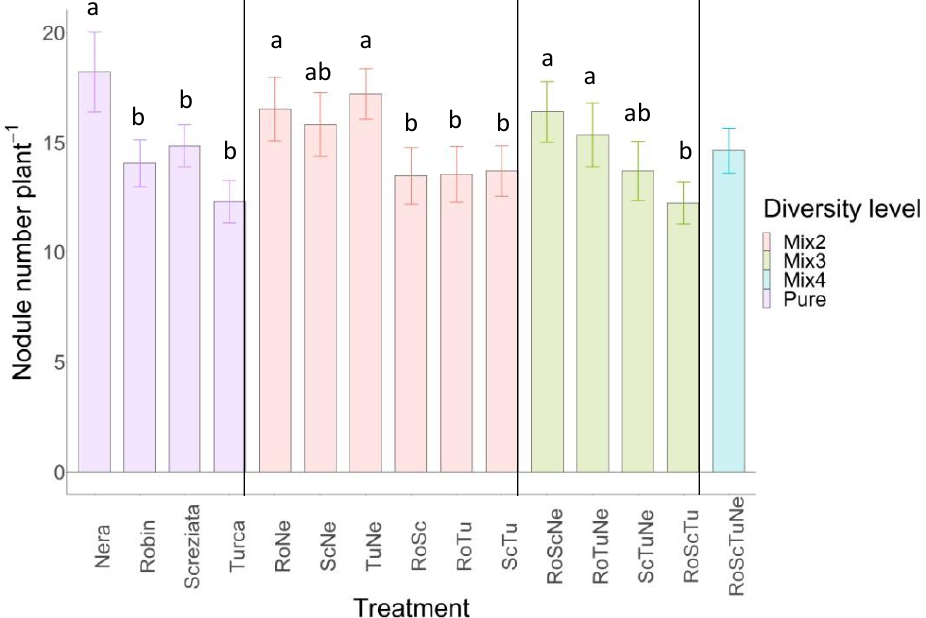
Figure 2. Nodule number per plant in pure lentil stands, two-, three- and four-cultivar mixtures, averaged over the three years of the experiment. Different letters indicate significant differences among treatments at p ≤ 0.05 (Bonferroni-based method). Ne = cv. Nera, Ro = cv. Robin, Sc = cv. Screziata, Tu = cv. Turca.